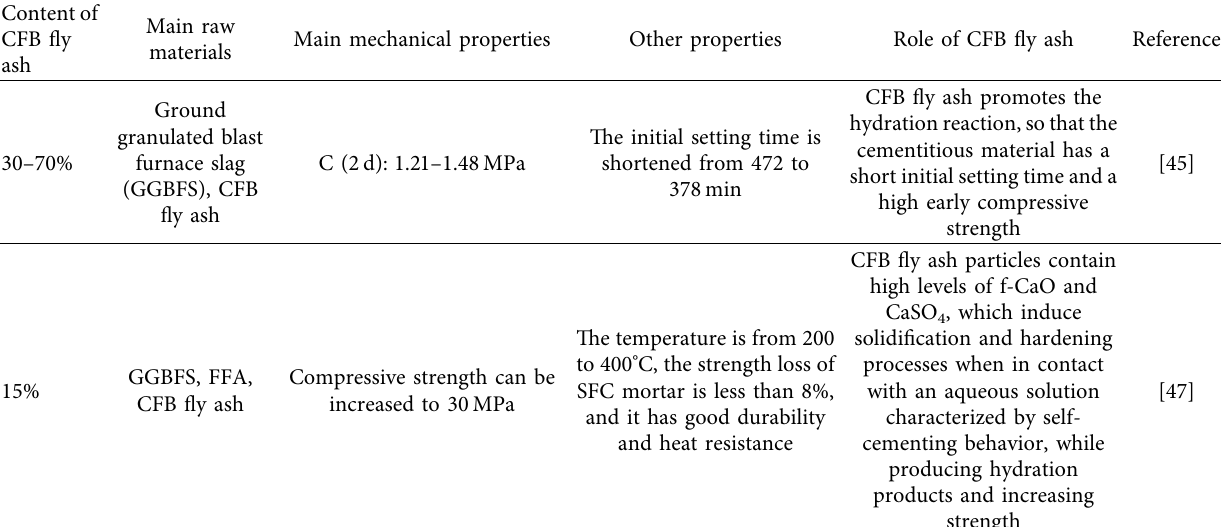
Table 4: Application of CFB fy ash in